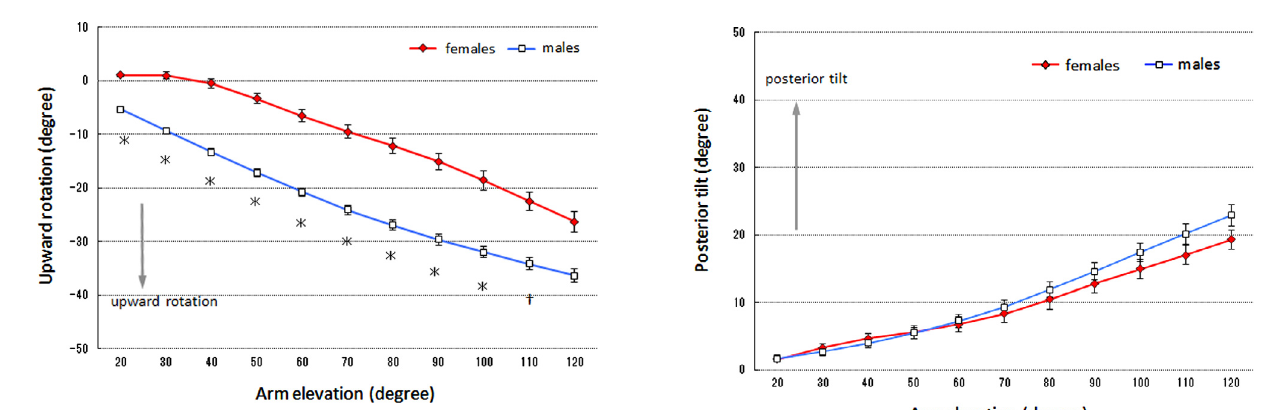
Figure 1. Mean scapular upward rotation. The error bars represent the standard error of the mean. * Significant difference ( p < 0.01) between groups. (cid:2) Significant difference ( p < 0.05) between